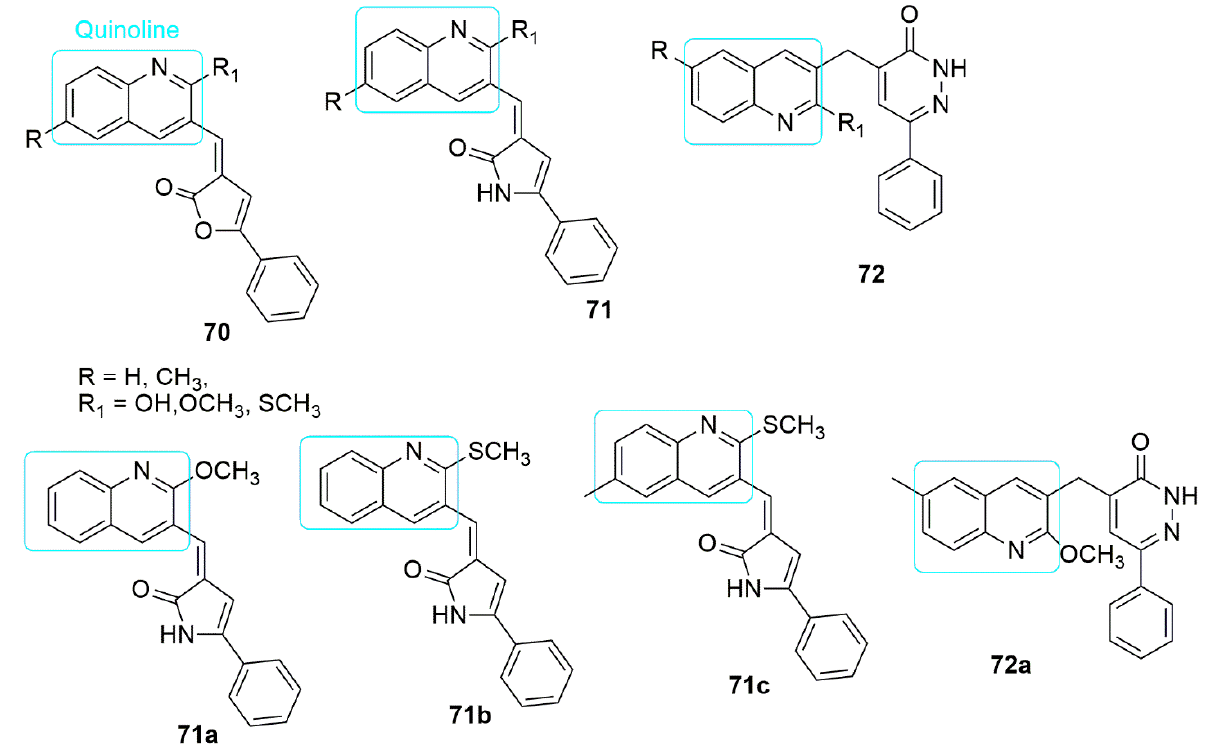
Figure 21. Chemical structures of quinoline conjugates as anti-tubulin agents. A series of novel quinoline–indole derivatives were synthesized by replacing 3,4,5- trimethoxyphenyl and isovanillin moieties of isoCA-4-bearing quinoline and indole rings by Li and et al. [66]. The synthesized compounds were evaluated for their anticancer and anti-tubulin activity. The cancer cells used in their study include human hepatocellular carcinoma (HepG2), epidermoid carcinoma of the nasopharynx (KB), human colon cancer cells (HCT-8), human breast cancer cells (MDA-MB-231), mouse liver cancer cells (H22), and human normal hepatocytes (LO2). Compounds bearing methyl 78a and hydroxymethyl 78b were more potent than the other groups against K562 cells and the five cancer cell lines with IC 50 values ranging from 5 to 11 µ M, which are comparable to the activity observed in CA-4. The active compounds ( 78a , R 1 = CH 3 , 78b , R = CH 2 OH) exhibited tubulin polymerization at IC 50 values of 2.54 and 2.09 µ M, which is comparable to that for CA-4 ( IC 50 = 2.12 µ M). It was found that compound 78a disintegrates microtubule assembly and arrests the cell cycle at the G2/M phase, inducing apoptosis and depolarizing mitochondria of K562 cells in a dose-dependent manner. In addition, the in vivo antitumor activity of 78a and 78b were corroborated in the H22 liver cancer xenograft mouse model. The result showed that 78a was able to suppress tumor volume and abridged tumor weight by 63.7% at the 20 mg/kg daily dose (i.v.). without obvious toxicity, which was more effective than CA-4 and CA-4P. (see Figure